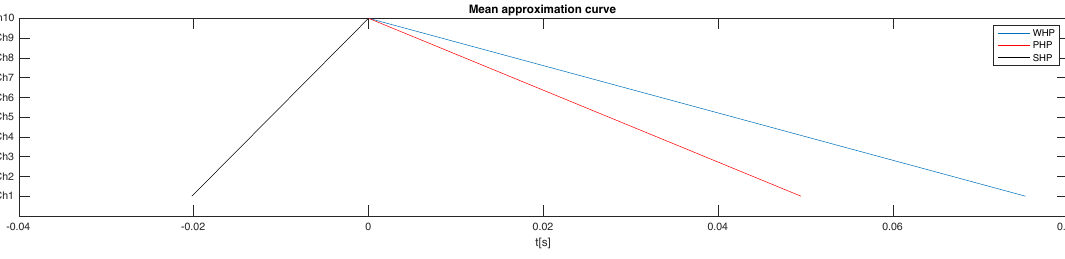
Figure 5. Mean approximation curve without using heel pad (WHP, blue line), with pronation heel pad (PHP, red line) and supination heel pad (SHP, black